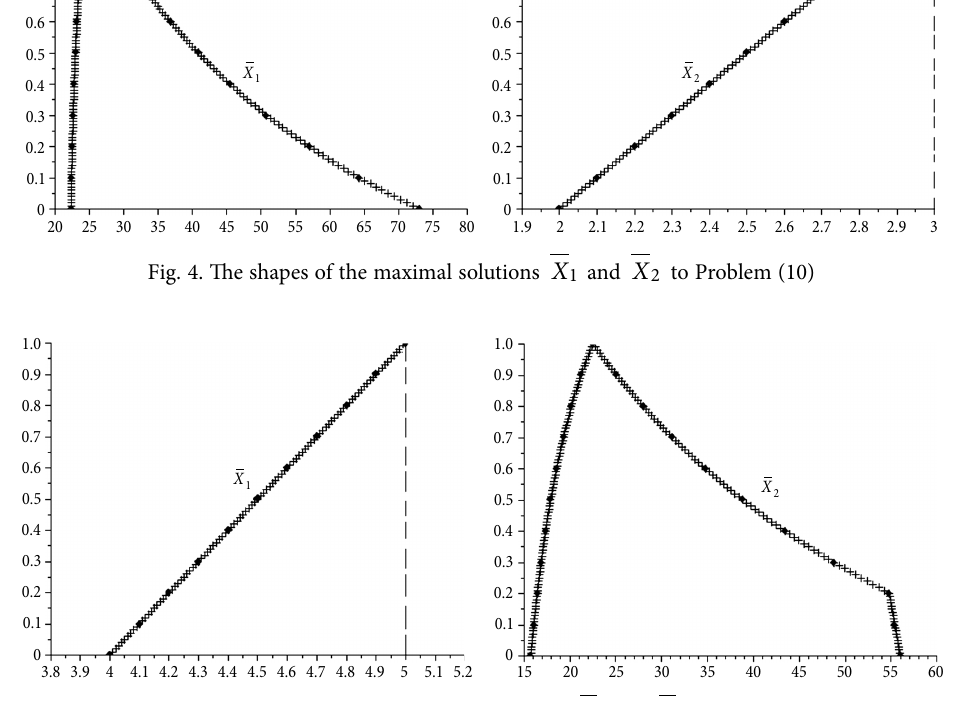
Fig. 5. The shapes of the minimal 1 X and 2 X